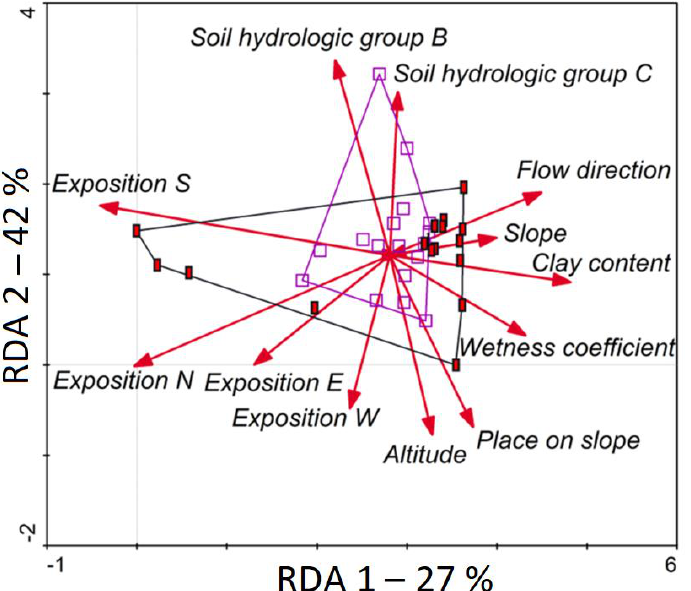
Figure 7. Multivariate RDA analysis for the soil moisture ratio is created by vectors (red squares are for convex; purple squares for concave slopes).